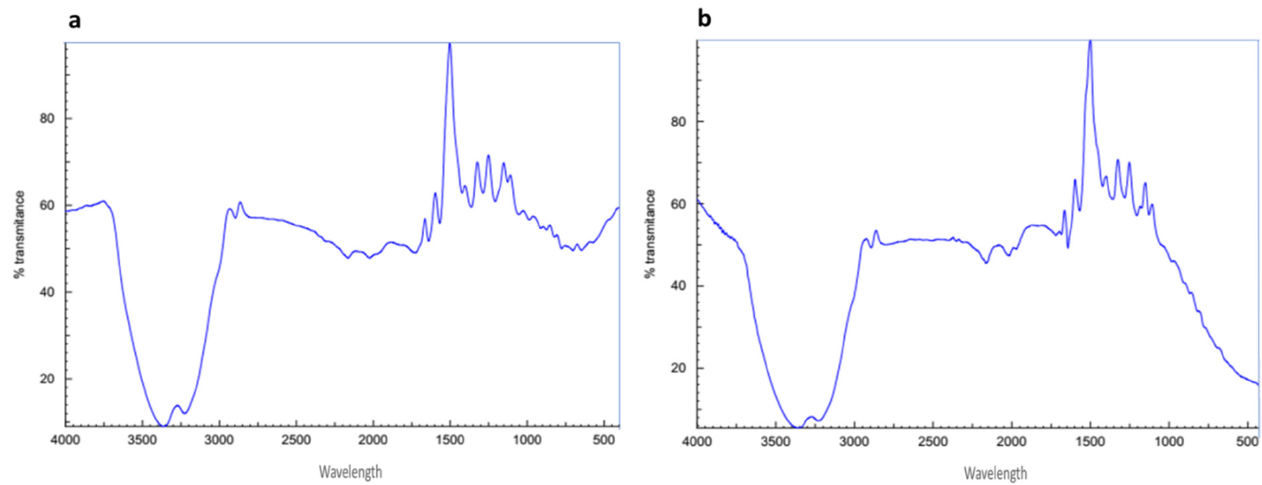
Figure 6. FTIR spectra for compound OM 1 ( a ) and the prepared AuNPs-OM 1 ( b ).